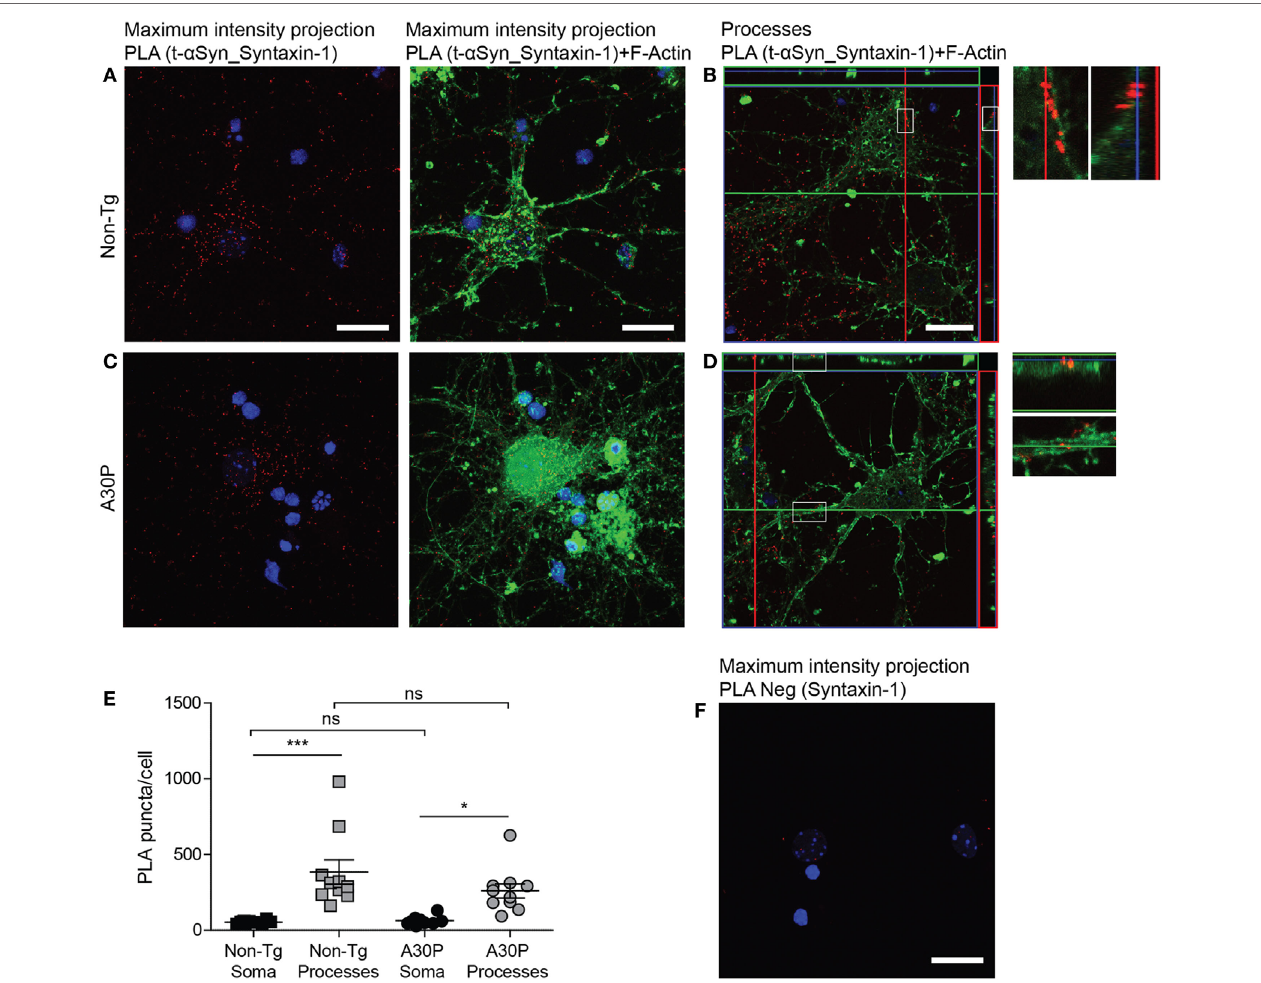
FigUre 5 | Representative confocal images of in situ proximity ligation assay (PLA) between alpha-synuclein ( α Syn) (mAb1338) and syntaxin-1 (red) in non-tg (a,B) and A30P (c,D) cortical primary neurons. Maximum intensity projections of a confocal z-stack including a whole cell were performed to observe the maximum amount of PLA puncta (a,c) . Cross section of the processes allows visualization of the PLA puncta in an orthogonal view ( B,D , inlet), scale bar 20 µm. F-actin stained by phalloidin-FITC (green) and DAPI (blue). Quantification of amount of PLA puncta per cell in the soma and processes. One-way ANOVA followed by Bonferroni post hoc test, non-significant (ns), *** P < 0.001. Error bars represent the SEM (e) Negative control PLA with syntaxin-1 antibody only (F) . Scale bar 50